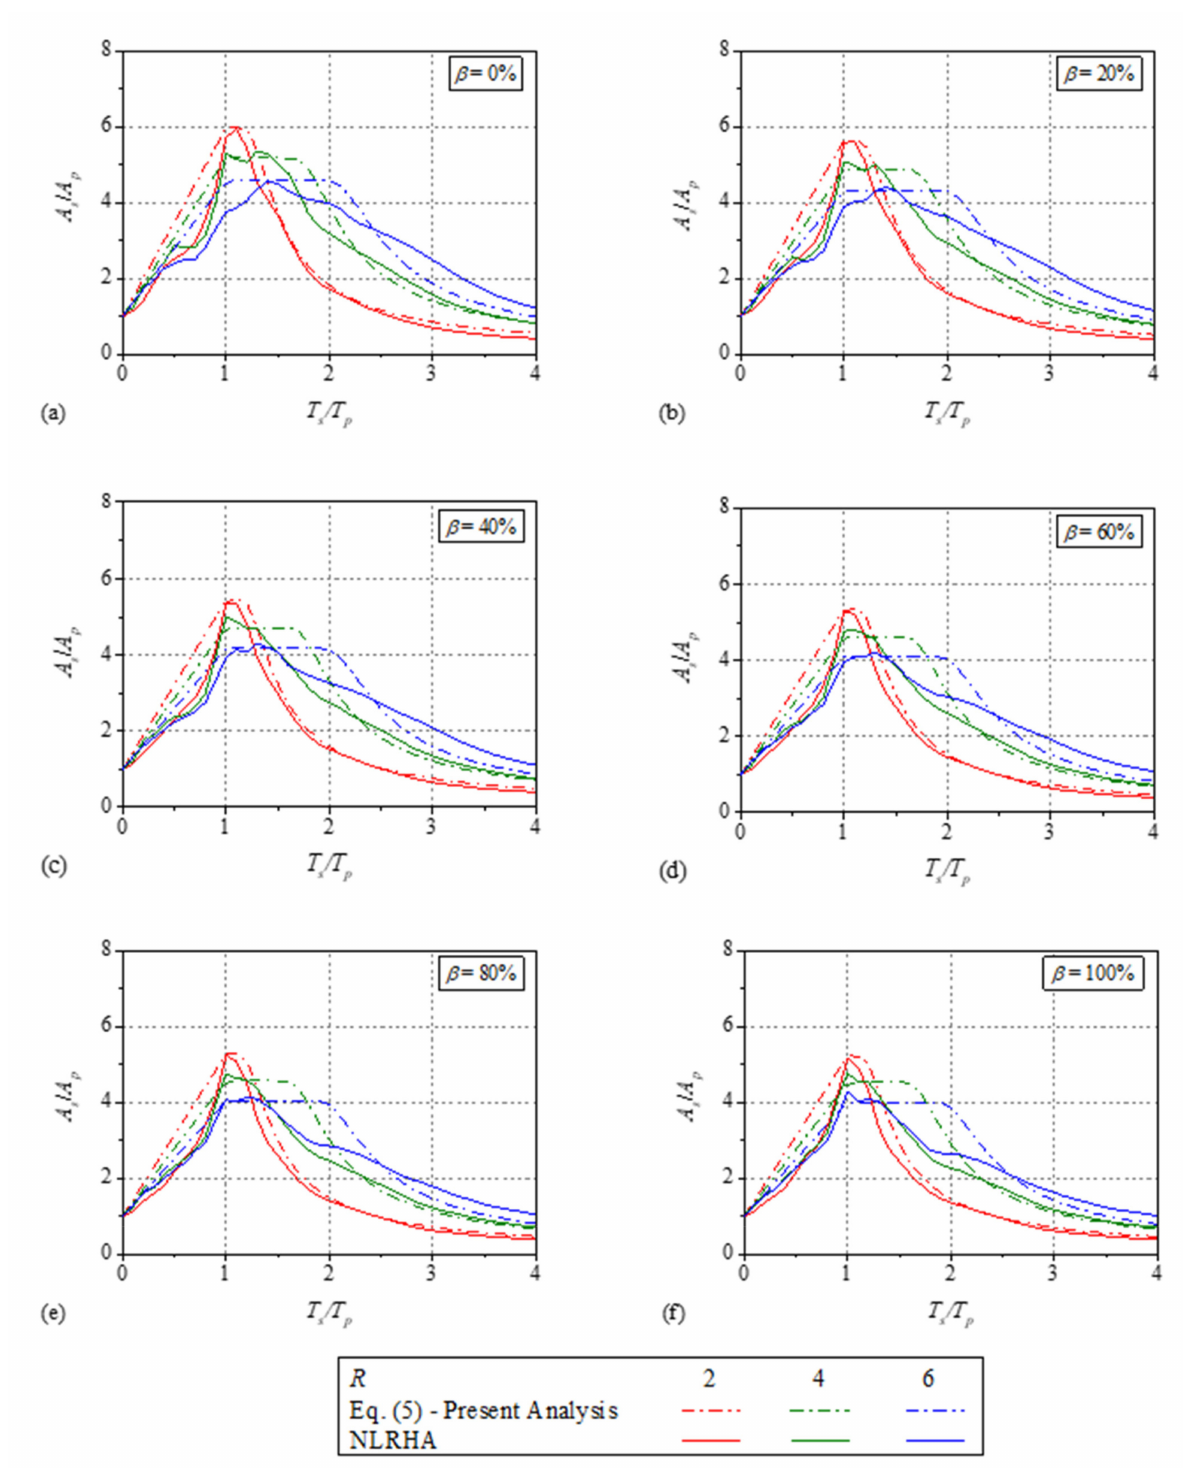
Figure A2. Comparison of the mean normalized floor response spectra from Equation (5) and for a primary structure with initial vibration period T p = 1.0 s: ( a ) β = 0%; ( b ) β = 20%; ( c ) β = 40%; ( d ) β = 60%; ( e ) β = 80%; and ( f ) β =